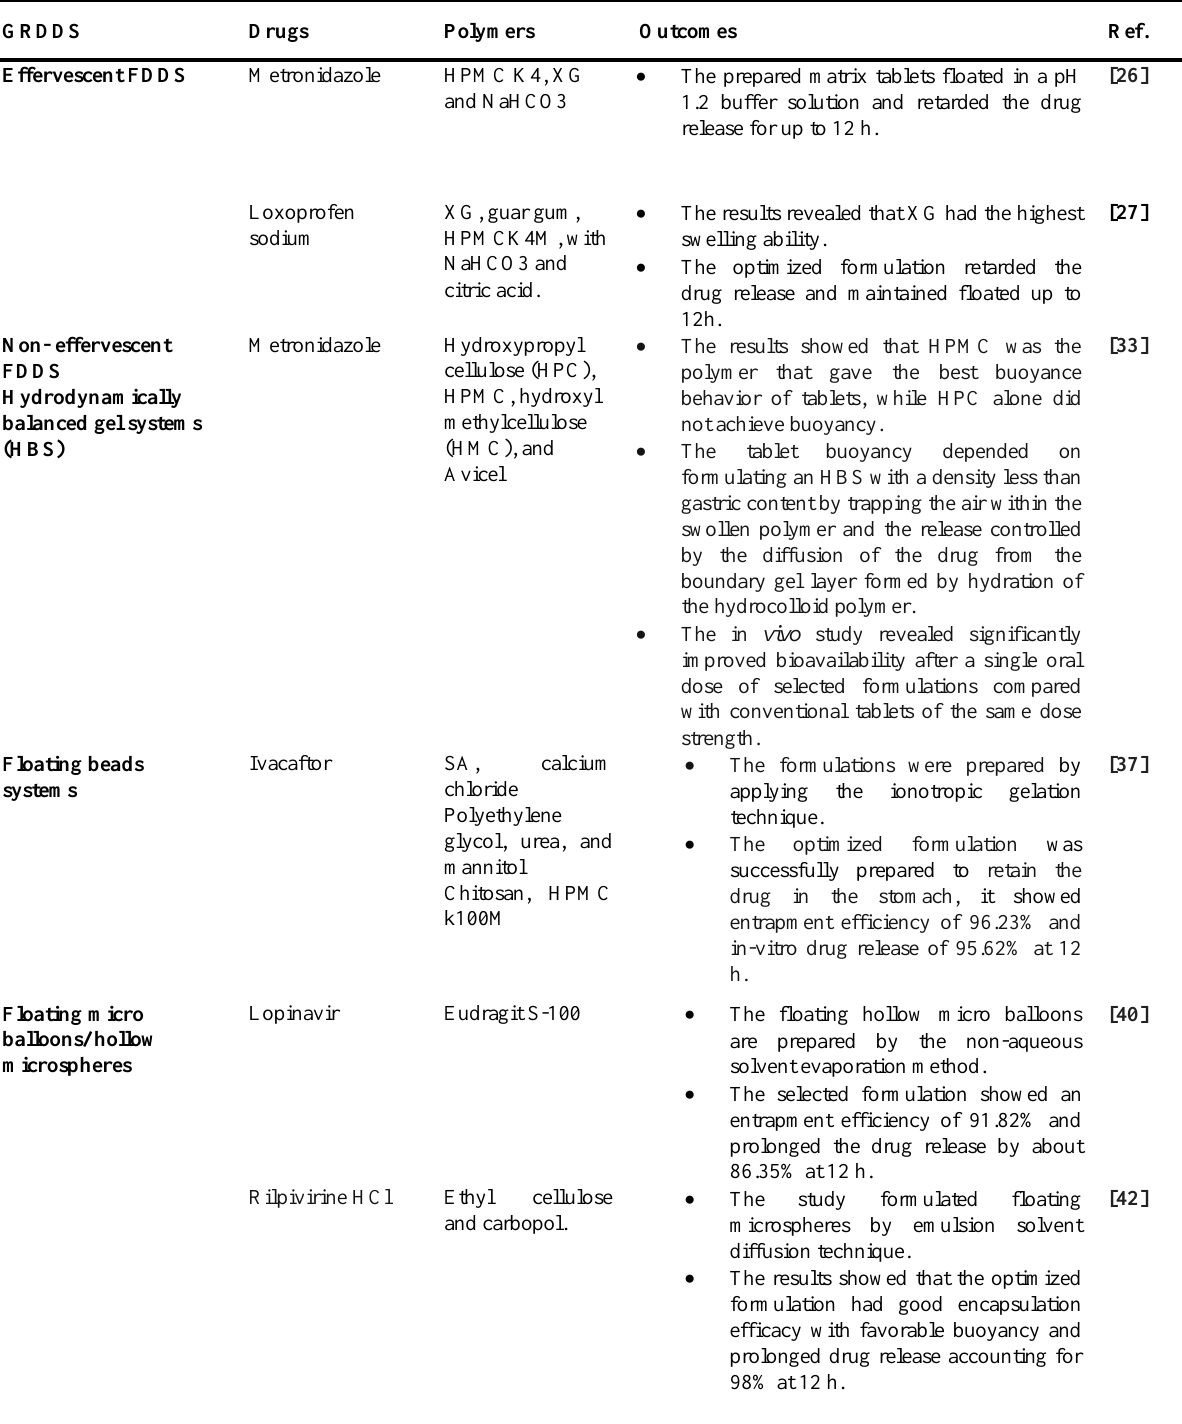
Table 2. List of drugs fabricated in various floating GRDDS